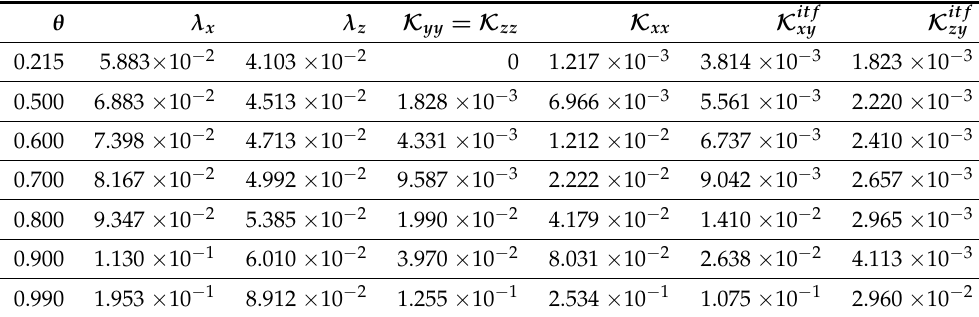
Table 1. Numerical values of the macroscopic coefficients at different values of the porosity, for the case of longitudinal cylindrical